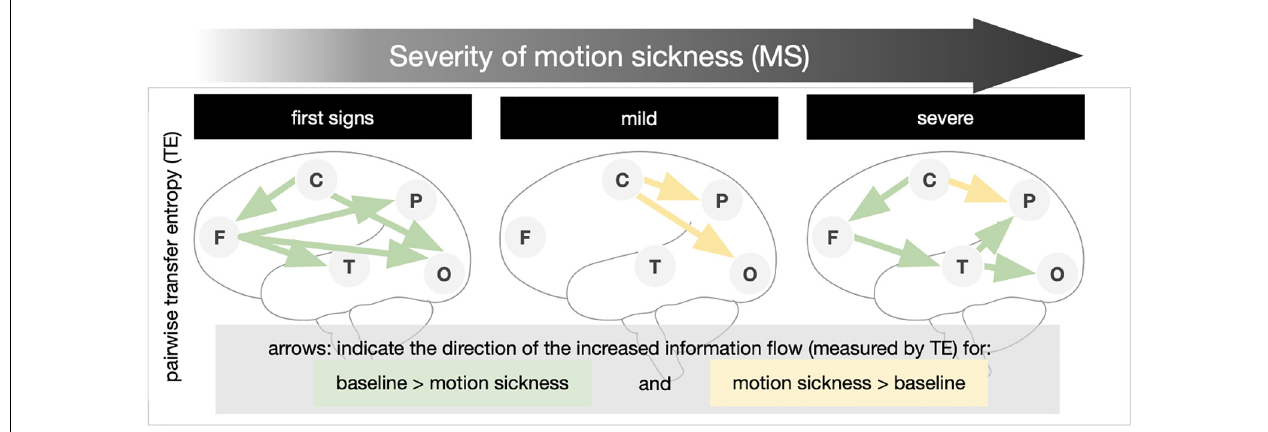
FIGURE 3 | Transfer entropy in levels of increasing motion sickness (MS). Pairwise transfer entropy (bivariate TE) was calculated for the difference of the baseline to (1) first signs of MS, (2) mild MS, and (3) medium/severe MS. The direction of the increased information transfer in comparison to the baseline condition is shown by arrows (results significant at p ≤ 0.05 in non-parametric permutation